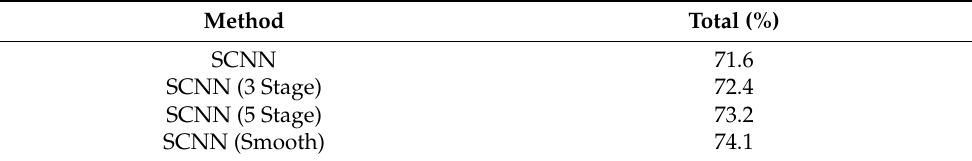
Figure 8. Visualize the lane line classification probability map generated by each algorithm. Table 4. Influence of different decoder structures on lane line detection performance %.